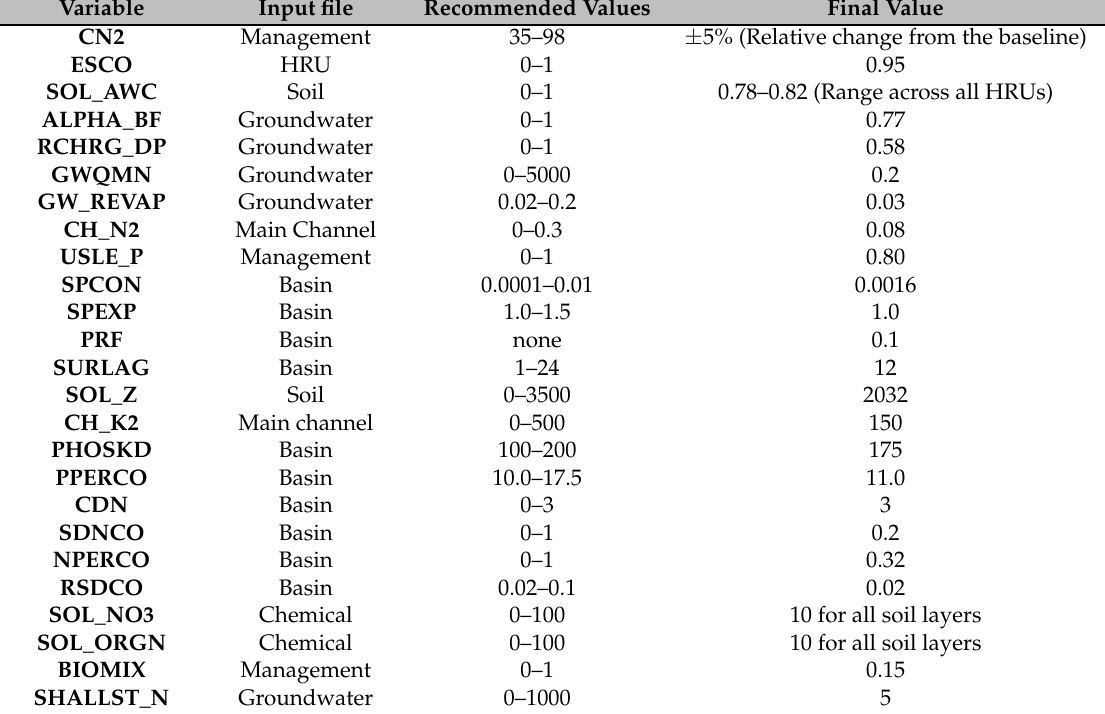
Table 7. Parameters adjusted for calibration. HRU: hydrological response units.